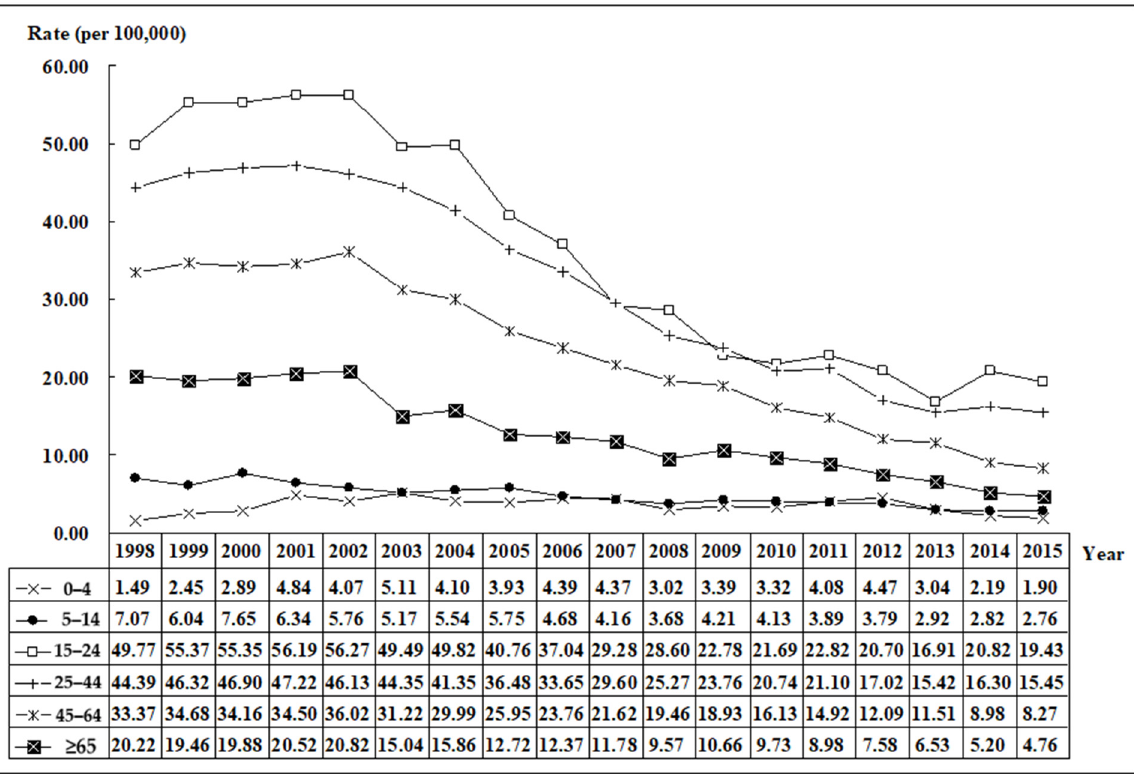
Figure 2. The trend of homicide hospitalization rates by age groups in Taiwan, 1998–2015.